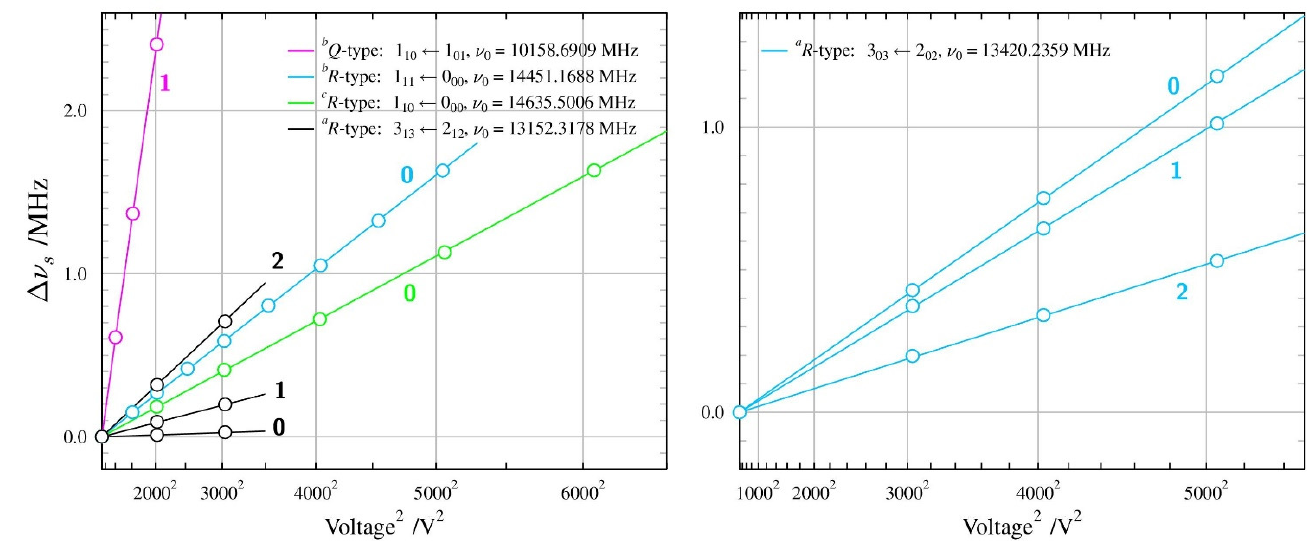
Figure 6. Summary of Stark measurements for the less stable GTg’ conformer of n -butanol (see the caption to Figure 3 for details). As in the most stable TGt conformer, it was possible to measure Stark lobes of transitions allowed by non-zero values of all three non-zero dipole moment components. A comparison of the determined dipole moments with the molecular structures of n - butanol is made in Figure 7. There is a marked similarity with a corresponding comparison for n -propanol in Figure 4, as the molecular dipole moment for the most stable conformer is aligned much more closely with the ∠ COH bisector than is the case in the less stable conformer. The distortion of the dipole moment direction in relation to the ∠ COH bisector for the less stable GTg’ conformer is also in the same direction and magnitude as for Aa n -propanol, i.e., towards the aliphatic